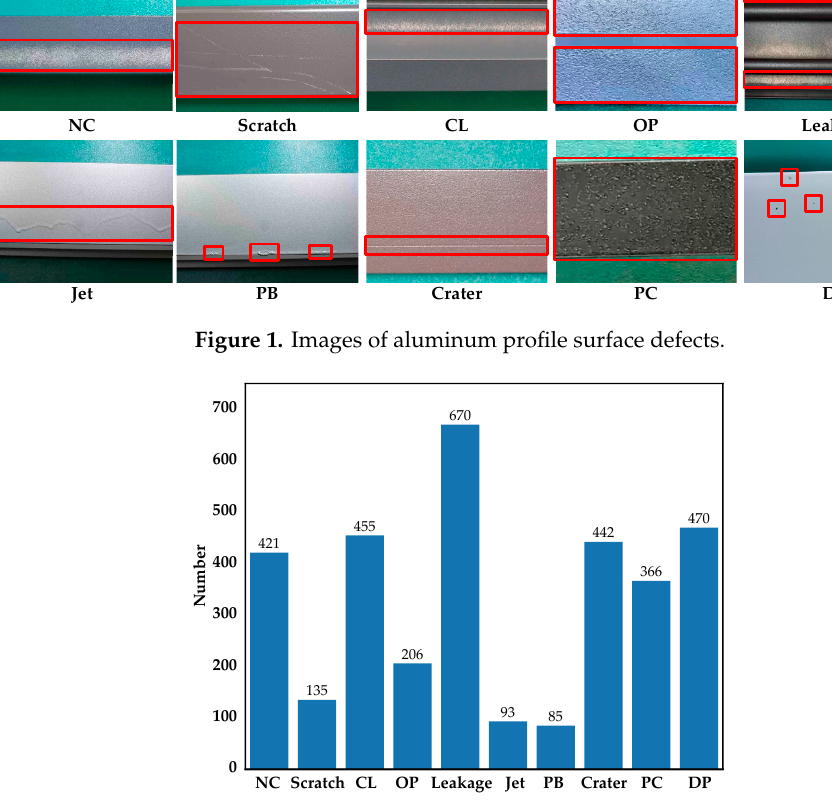
Figure 2. Diagram of the number of images with defects in each category.